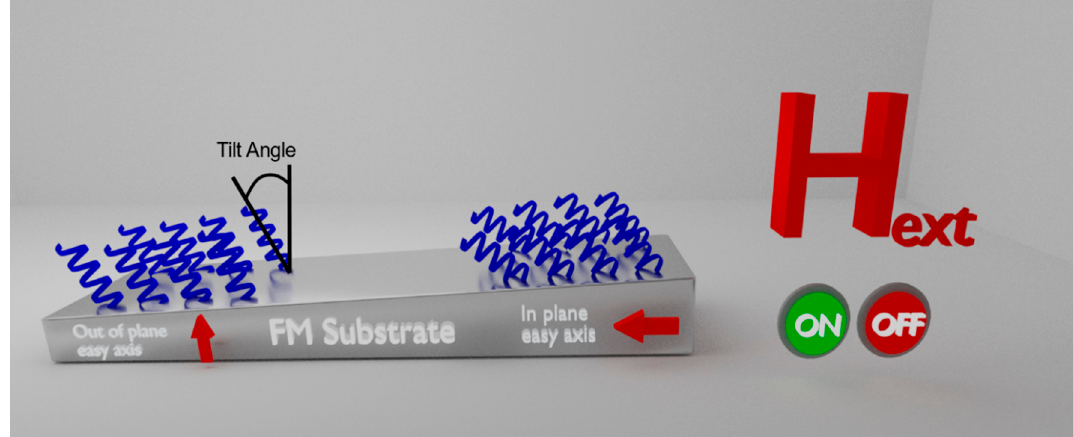
Figure 1. Schematic illustration of the experimental setup. A gradient thickness of ferromagnetic Co substrate with a transition between in plane to out of plane easy axis on which alpha helix L-polyalanine chiral molecules are selectively adsorbed. The tilt angle (defined in the figure) and magnetization are measured using MFM. The experiment is repeated when an external magnetic field (3000 Gauss) is applied both in plane and out of plane during the adsorption process.